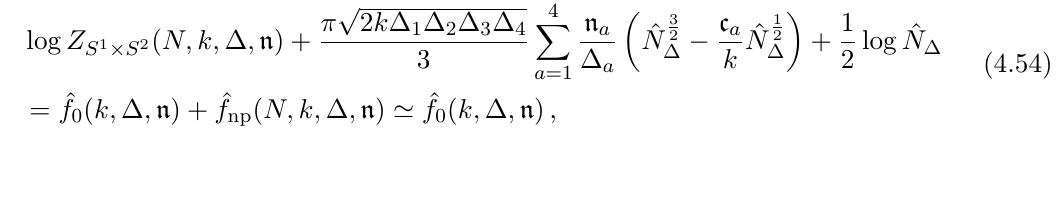
Figure 3 . Black/blue/magenta/cyan points represent the numerical coefficients the fit (4.52), and red/orange/green/brown lines represent the analytic expressions ˆ f the r.h.s. of (4.53) for a ∈ { 1 , 2 , 3 , 4 } , respectively. The symbol ∆ ∗ stands for the superconformal configuration ∆ = 1 and x parametrizes the deviation from it. In the left and right panels, we a 2 consider two different deviations of flavor chemical potentials from the superconformal configuration with x ∈ { 1 , 2 , · · · , 1 } 100 100 10